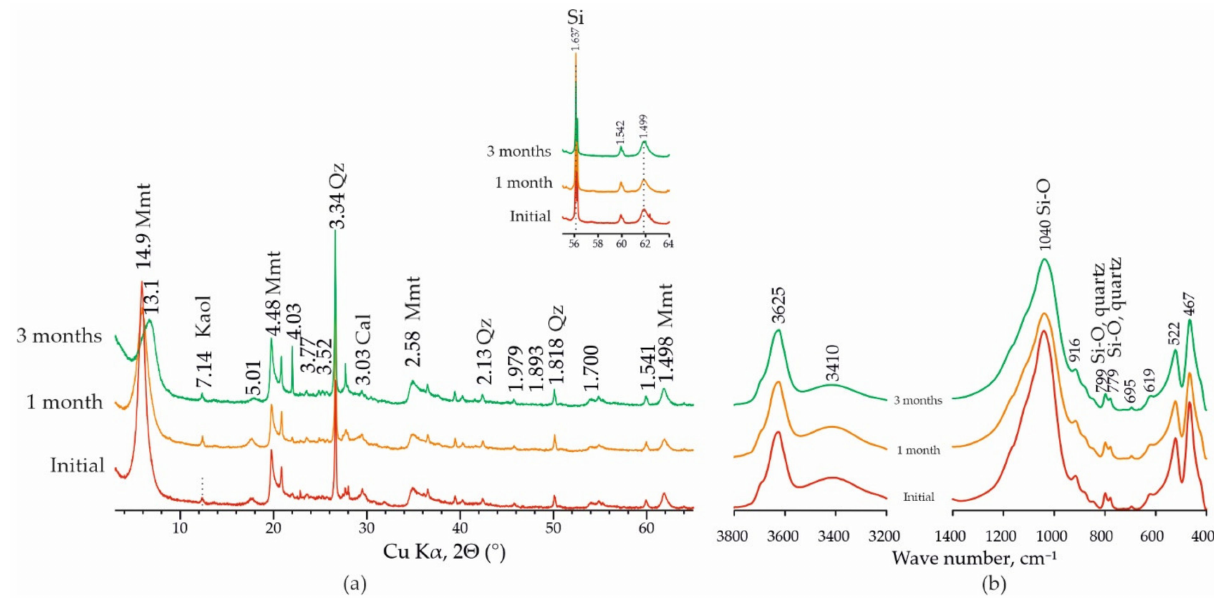
Figure 7. ( a ) X-ray diffraction patterns of the samples; ( b ) IR spectra of the